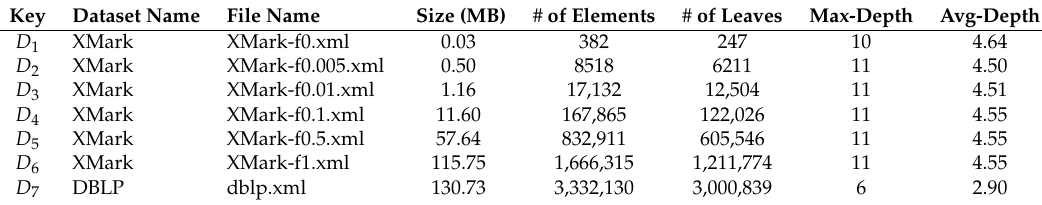
Table 1. Characteristics of the datasets.